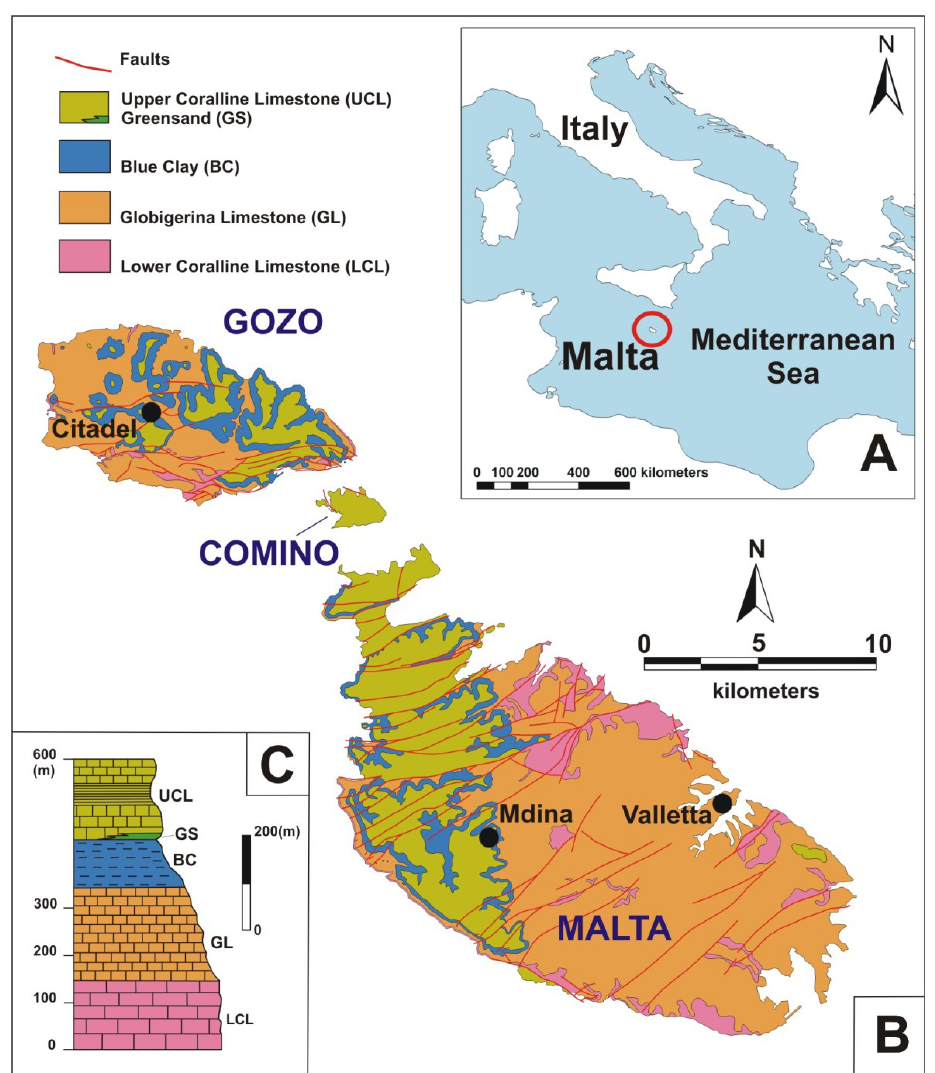
Fig. 2. Geographic setting (A) , simplified geological map (B) and stratigraphic column (C) of the Maltese Archipelago (modified after Pedley et al.,